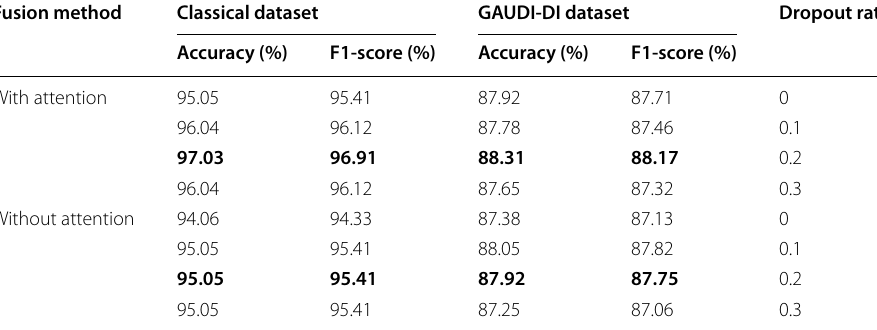
Bold means the best performance of tampering detection in the same experimental setting